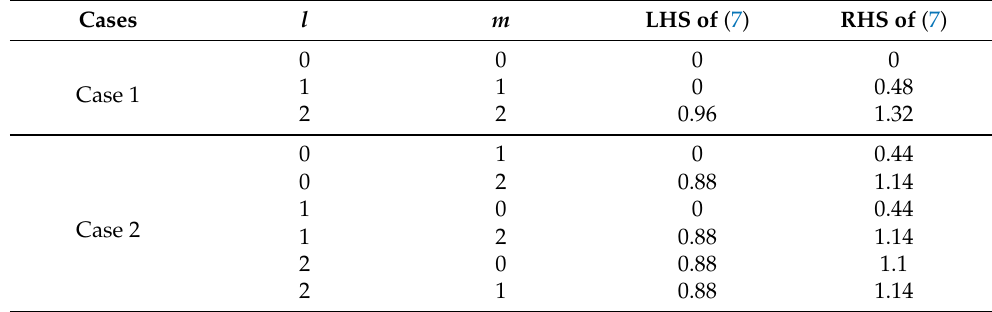
Table 1. Table of values for Cases 1 and 2.